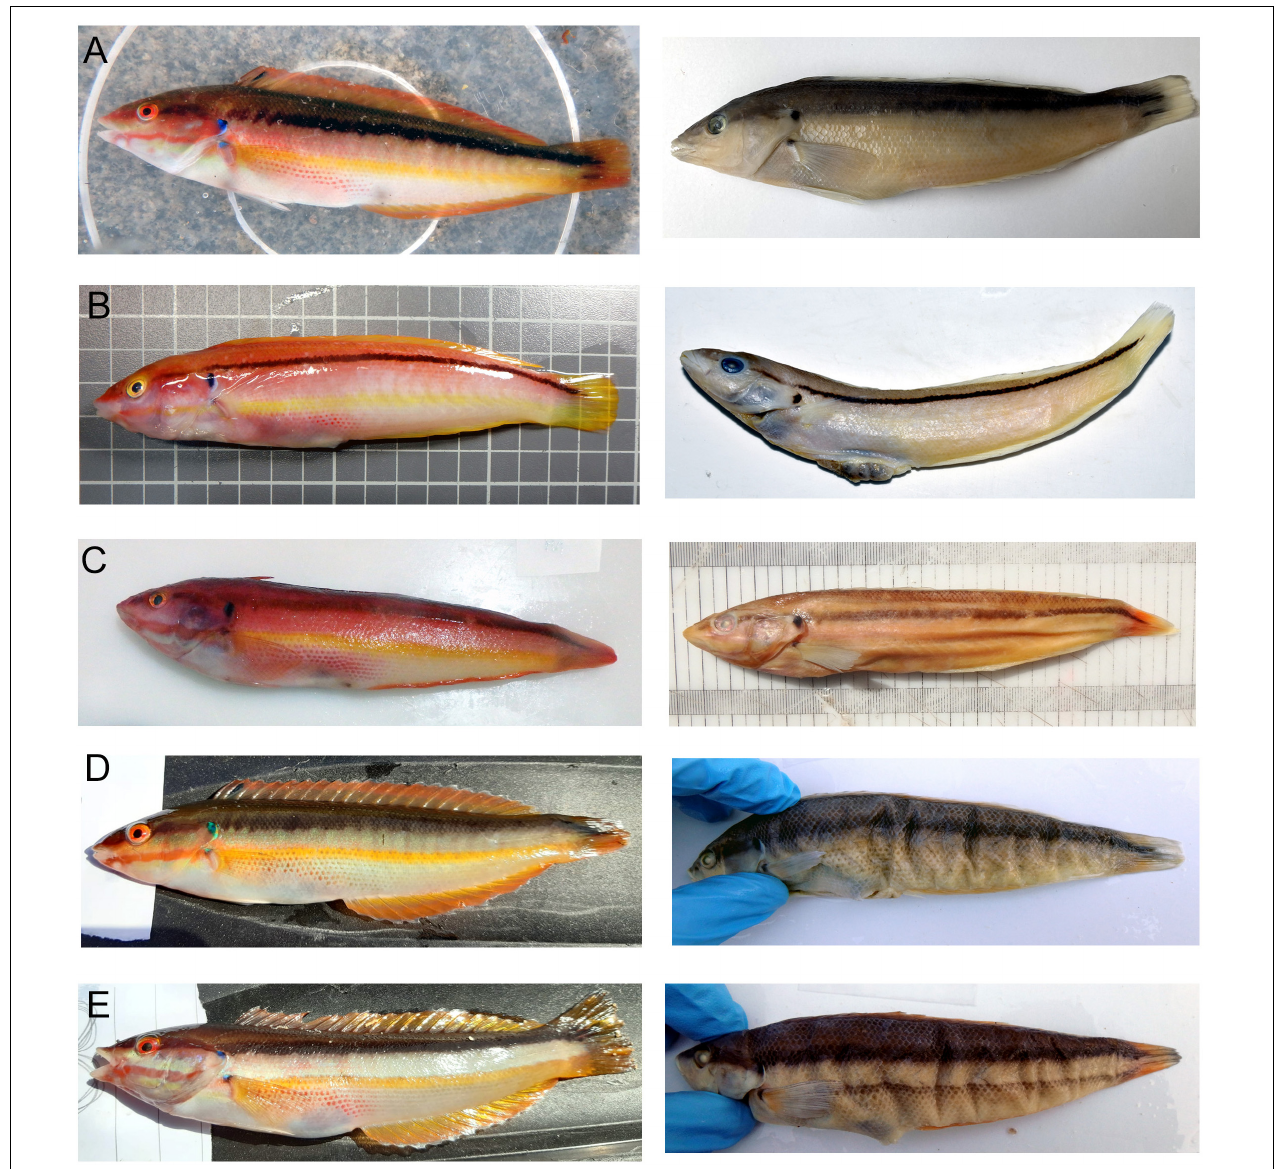
FIGURE 2 | Photographs of fresh and preserved specimens of Coris melanura showing the primary livery. (A) CFM-IEOMA 7441 from La Caleta, Cádiz, Gulf of Cádiz, Atlantic Ocean (the dark mark between DII and DIII is evident in this specimen); (B) CFM-IEOMA 7416 from Balearic Islands, Mediterranean Sea; (C) CFM-IEOMA 7417 from Santander, Bay of Biscay, Atlantic Ocean; (D,E) CFM-IEOMA 7422 and CFM-IEOMA7424 from Faro, Gulf of Cadiz, Atlantic Ocean, respectively. The fresh and preservation in formalin color are disposed in right and left site, respectively.